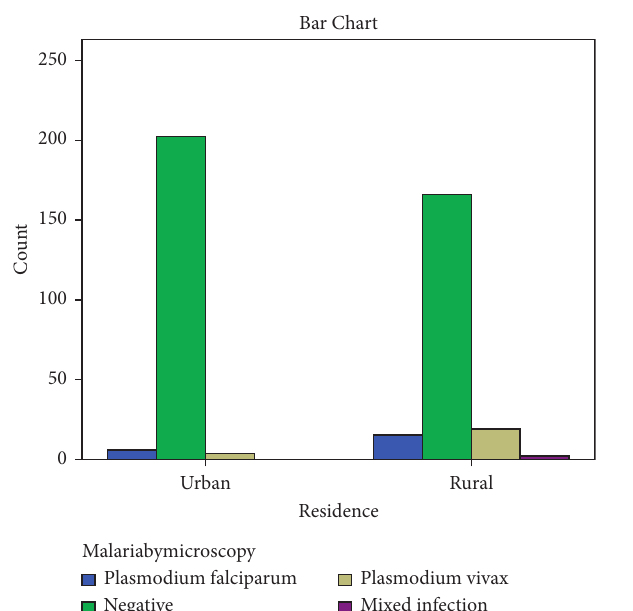
Figure 2: The prevalence of asymptomatic malaria among urban and rural residence of primary school children in Gedeo zone, Southern Ethiopia. Table 3: Prevalence of intestinal helminths among age and sex groups of primary school children in Gedeo zone, Ethiopia. Prevalence of helminths N